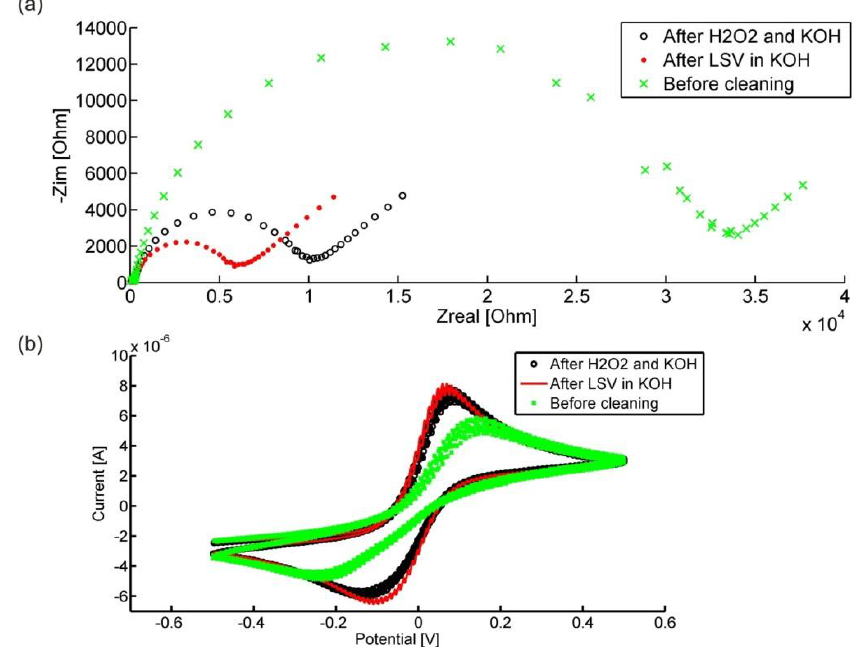
Figure 8. CVs ( a ) and EIS spectra ( b ) recorded on all of the 12 WEs using the on chip reference and counter electrodes for each measuring site. The CVs and EIS spectra are well superimposed on each other, presenting practically identical peak potentials and currents as well as impedance on each of the 12